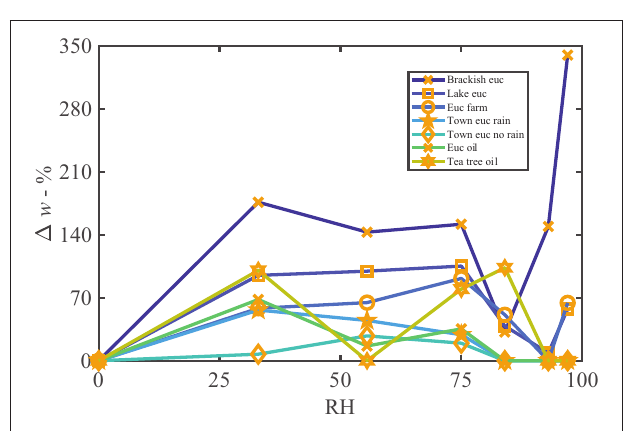
FIGURE 5 | Percentage weight gain of moisture vs. relative humidity of all Eucalyptus leaf wash samples, along with two oil controls for comparison. The oils contributed to the increasing sorption at low humidity and then decrease in sorption between 33 and 84%RH, while the other hygroscopic ionic compounds present in the sample contributed to weight gain at high humidities such as shown by “Brackish euc.” The oil controls follow a similar trend to the leaf